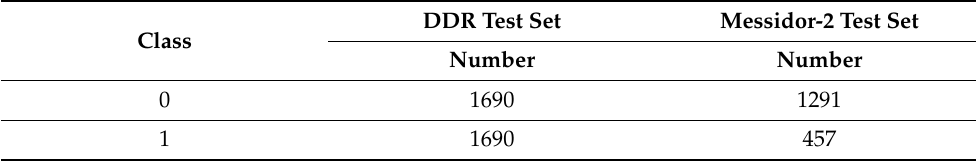
Table 2. Test datasets were constructed from DDR and Messidor-2 data.